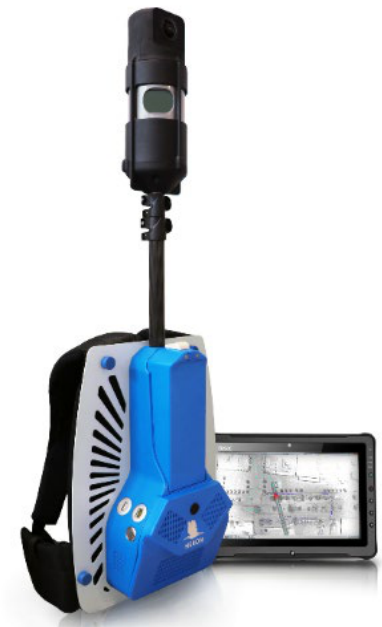
Figure 1: Particular of the Heron